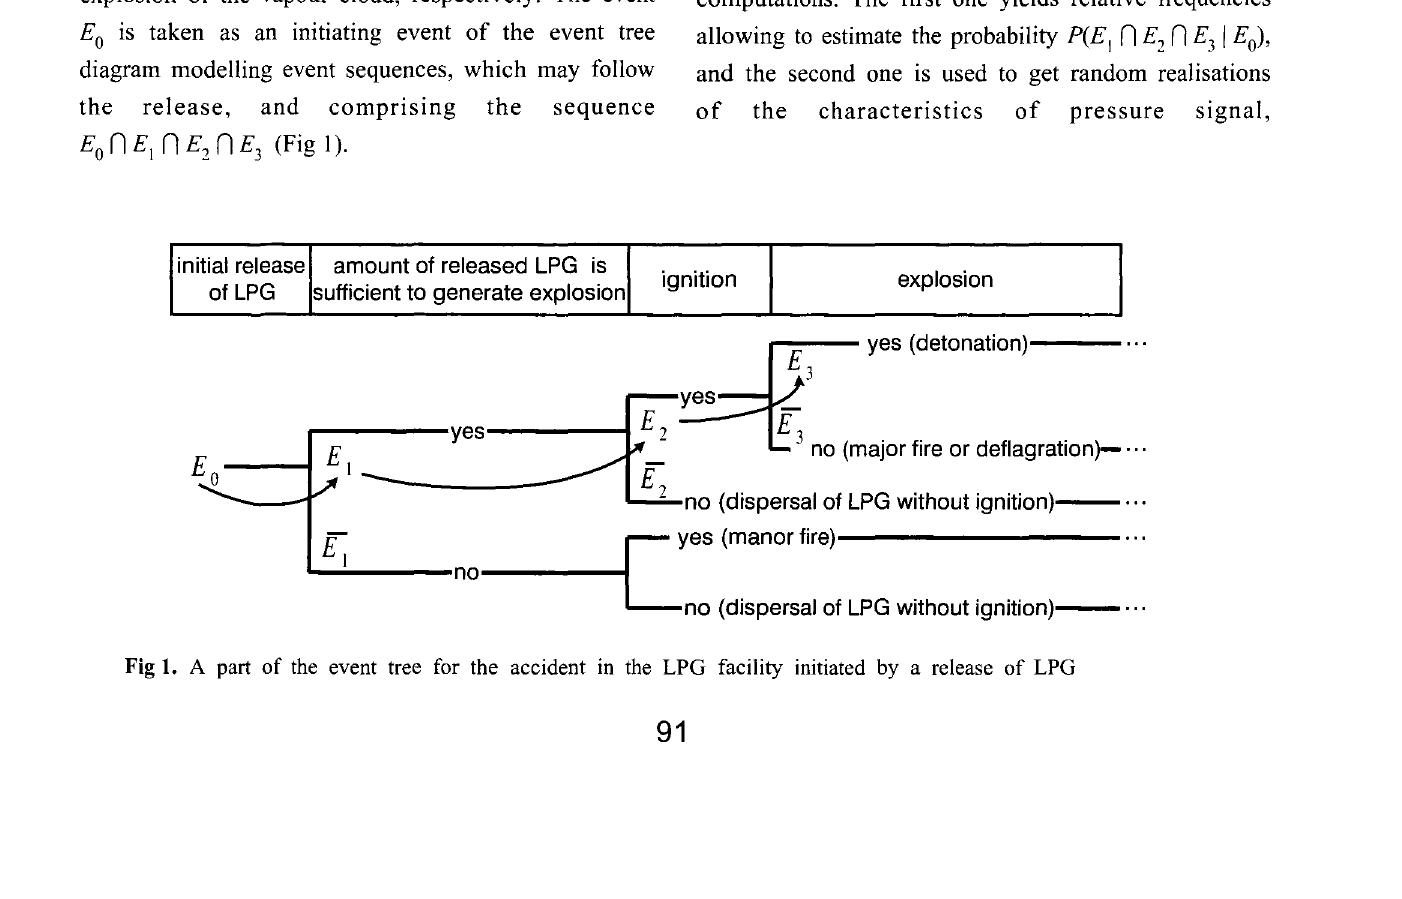
Fig 1. A part of the event tree for the accident in the LPG facility initiated by a release of